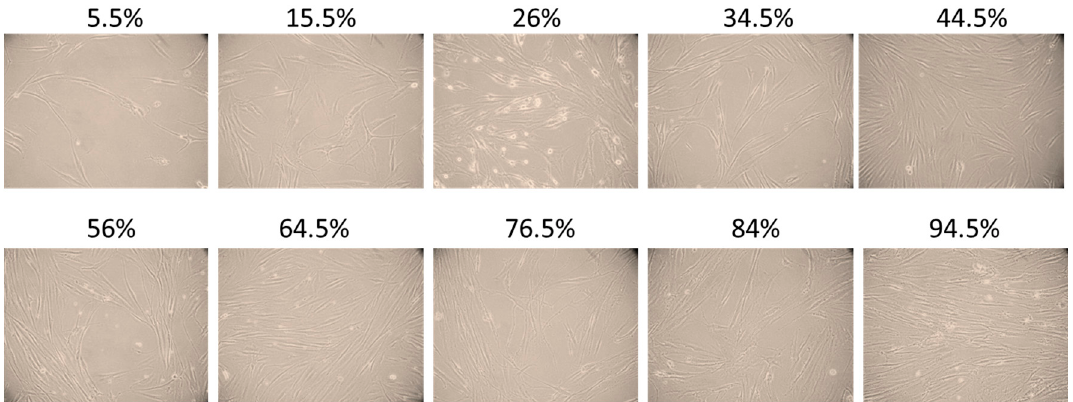
Figure 1. Typical cell images of different confluence levels, from 5.5 to 94.5%. These are the raw color images. The algorithm designed in this study was used to calculate the confluence percentages of these